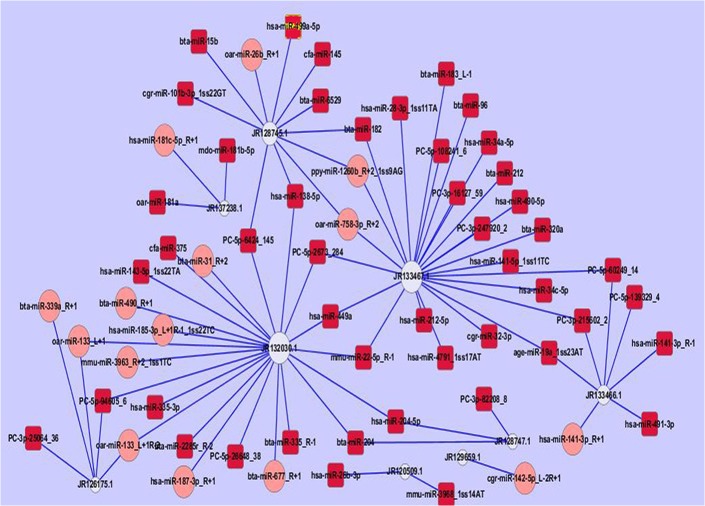
miRNA-gene network of induction of apoptosis by extracellular signals (GO: 0008624).Note: White circular nodes represent genes, and red rectangular and pink rounded rectangle nodes represent miRNAs. The size of the nodes represents the power of the interrelation among the nodes, and edges between two nodes represent interactions between genes. The more edges a gene has, the more miRNAs that interact with it, and the more central a role it had within the network. The top five key miRNAs in the network were miR-449a, miR-182, PC-5p-6424_145, PC-5p-2673_284, and miR-138-5p. The top three key mRNAs’ serial numbers were JR128745.1 (Caspase 8, apoptosis-related cysteine peptidase (CASP8)), JR133467.1 (Y-linked ubiquitin-specific protease 9 (USP9Y)), and JR132030.1 (CD5 molecule (CD5)) in NCBI (National Center for Biotechnology Information).